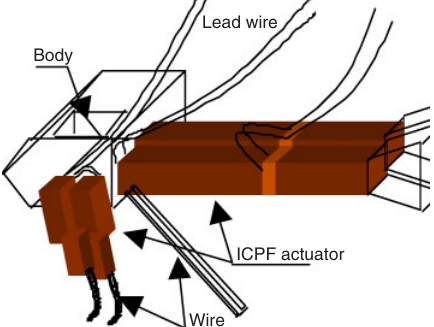
Figure 6 Adjusting mechanism of hybrid micro-robot.